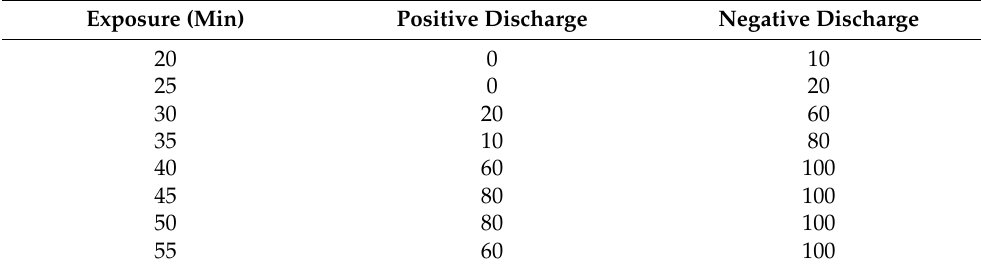
Table 1. Efficacy of positive and negative discharge to inactivate Acanthamoeba cysts in suspension. Inactivation of cysts after discharge exposure is expressed as a percentage.